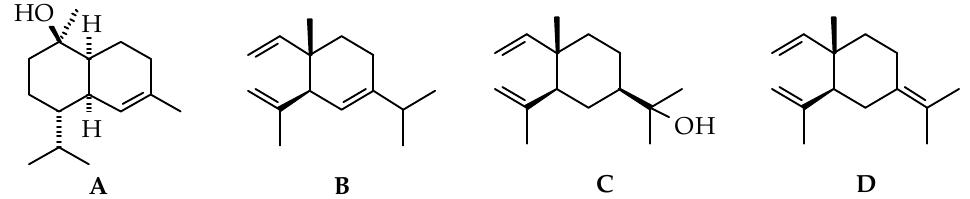
Figure 1. The main volatile compounds found in the leaves of black pepper cultivars. ( A ) α -muurolol; ( B ) δ -elemene; ( C ) elemol; ( D ) γ -elemene.